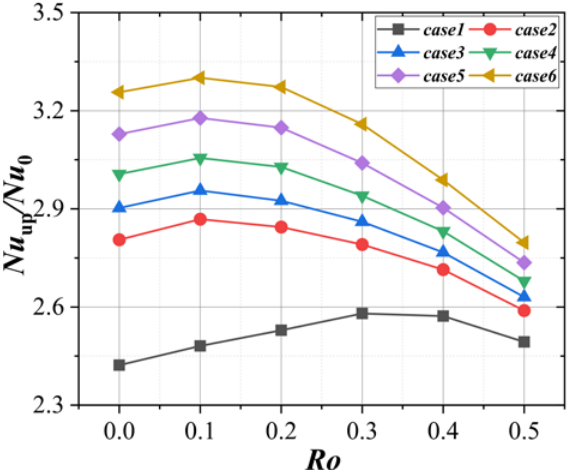
Figure 18. The variation of Nu up /Nu 0 with Ro .